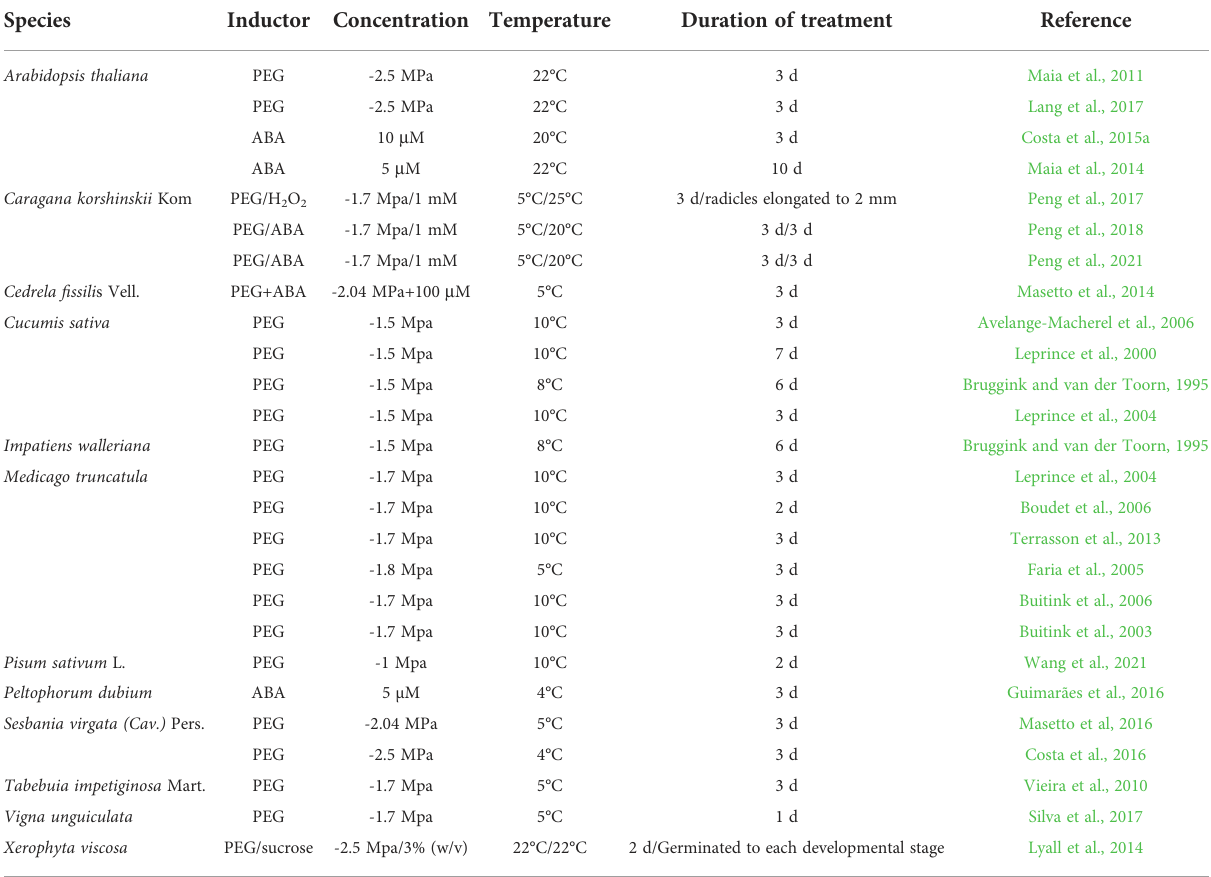
TABLE 2 The studies of re-establishment DT in germinating seeds.